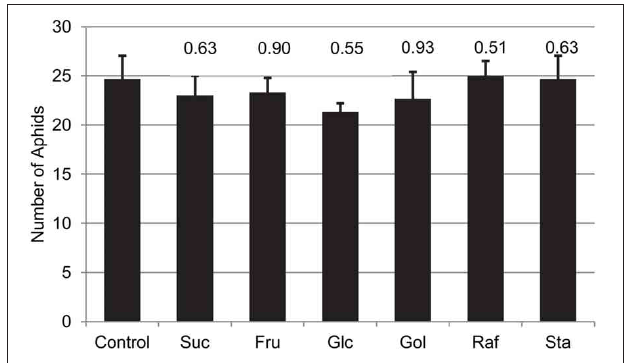
FIGURE 8 | The impact of the indicated sugar on aphid populations fed an artificial diet for 96h. Three adult aphids were released into the feeding chamber and allowed to feed on the diet through the sachet. The total number of aphids (adults + nymphs) were determined 96h later. Average and SE, n = 3 replicates; t -test p -values, relative to diet without supplemental sugar are indicated on the